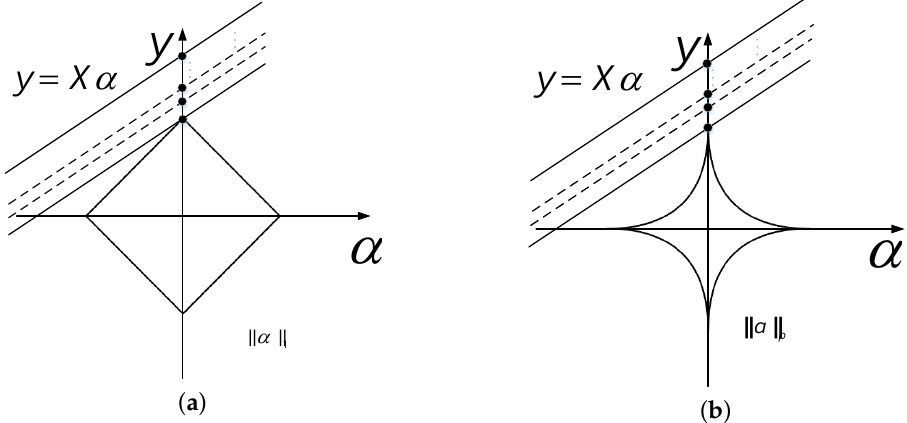
Figure 2. The scenograph of solutions for different norm minimization in 2-D space. ( a ) The scenograph of the solutions for l 1 -norm minimization. ( b ) The scenograph of the solutions for l p -norm